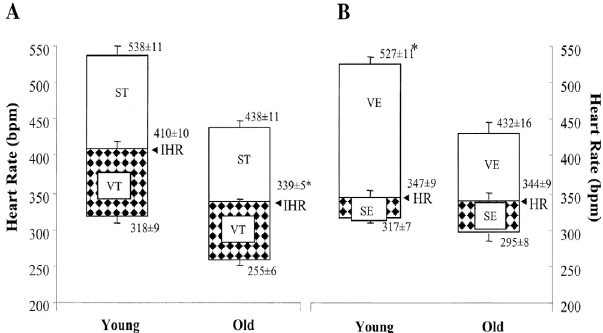
Figure 1 - A : Graphs showing no differences in sympathetic (ST) and vagal (VT) tone between young and old rats. The intrinsic HR (IHR) was lower in old rats. B : The increase in HR (from 347 ± 9 to 527 ± 11 beats/ min) after methylatropine injection [vagal effect (VE)] was higher in young rates than in older specimens. * Significant difference between young and old rats ( P < 0.05).